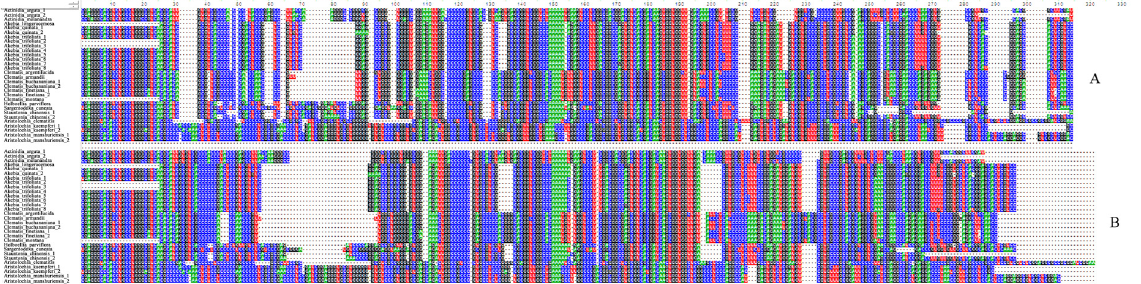
Fig 2. Comparison of multiple sequence alignments from different methods. a. alignment from MARNA with secondary structure guiding; b. alignment from Clustal X without secondary structure guiding.